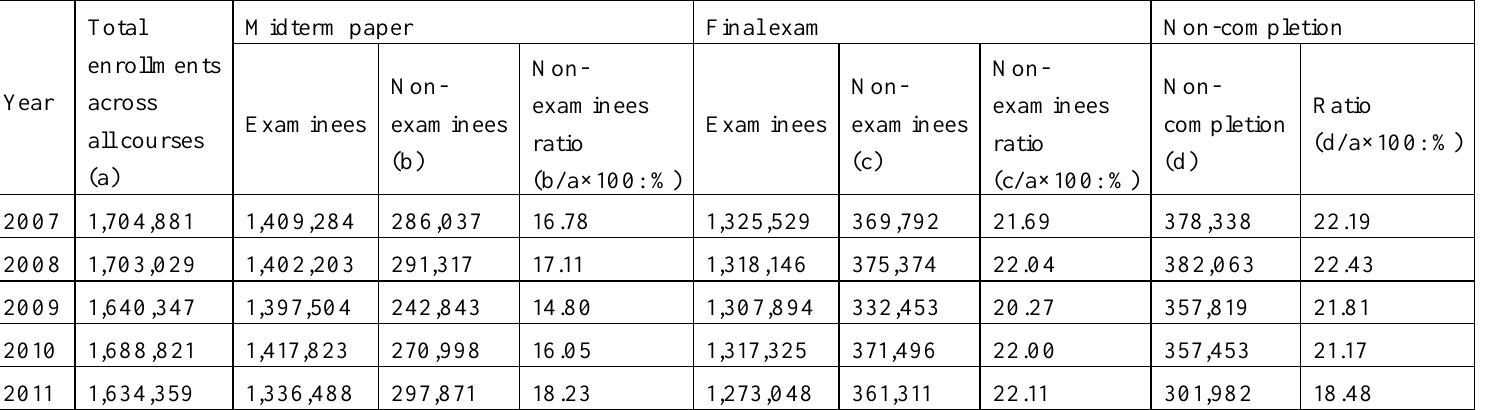
Course Non-Completion Rate: 2007 to